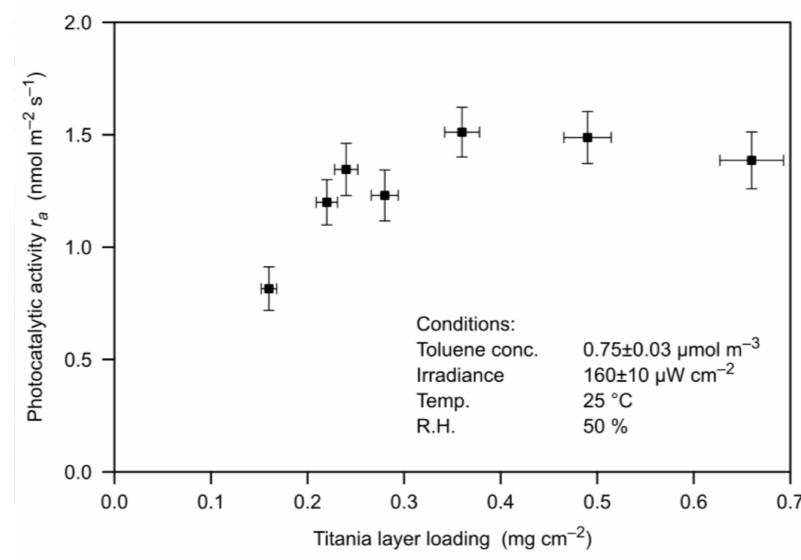
Figure 4. Photocatalytic toluene degradation activity of screen-printed titania samples made with Degussa Aeroxide P25 [22] in the experimental conditions indicated inside the